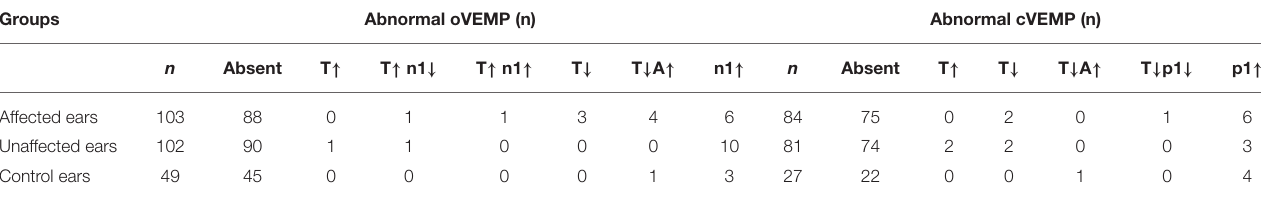
TABLE 2 | Abnormal parameters of vestibular-evoked myogenic potentials (VEMPs) in affected, unaffected and control ears. Groups Abnormal oVEMP (n) Abnormal cVEMP (n)